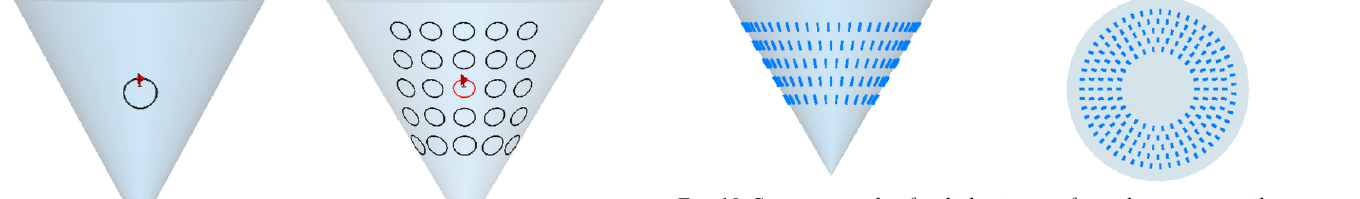
Fig. 10. Structure made of radial strips conformed on a cone: side (left panel) and top (right panel) views